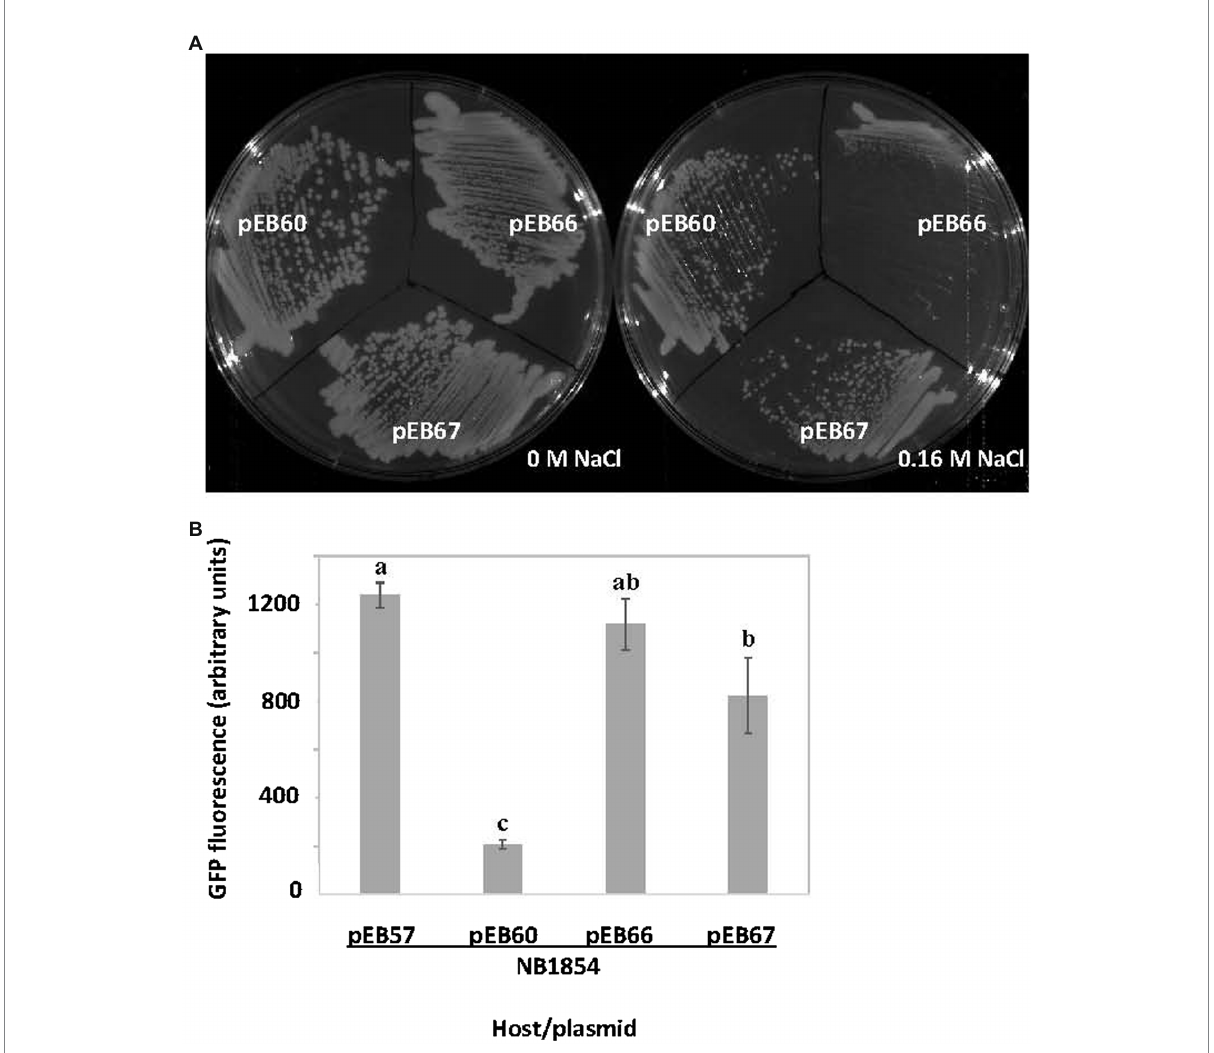
FIGURE 5 Effects of cysteine substitution mutation in SrlA thioredoxin fold. (A) the pEB60 (wt srlA ORF) derivative pEB67 carrying a C61S substitution mutation complements the salt-sensitive phenotype of ∆ srlA strain NB1854. (B) the C61S SrlA substitution mutant expressed from pEB67 does not fully repress the srlA promoter as compared with expression of wt SrlA from pEB60. pEB66 is a pEB60 derivative carrying an in-frame deletion in the srlA ORF and can neither complement nor repress promoter. GFP activity reported as mean ± sd, n = 3. Letters indicate whether means are significantly different ( p < 0.05, ANOVA and Tukey